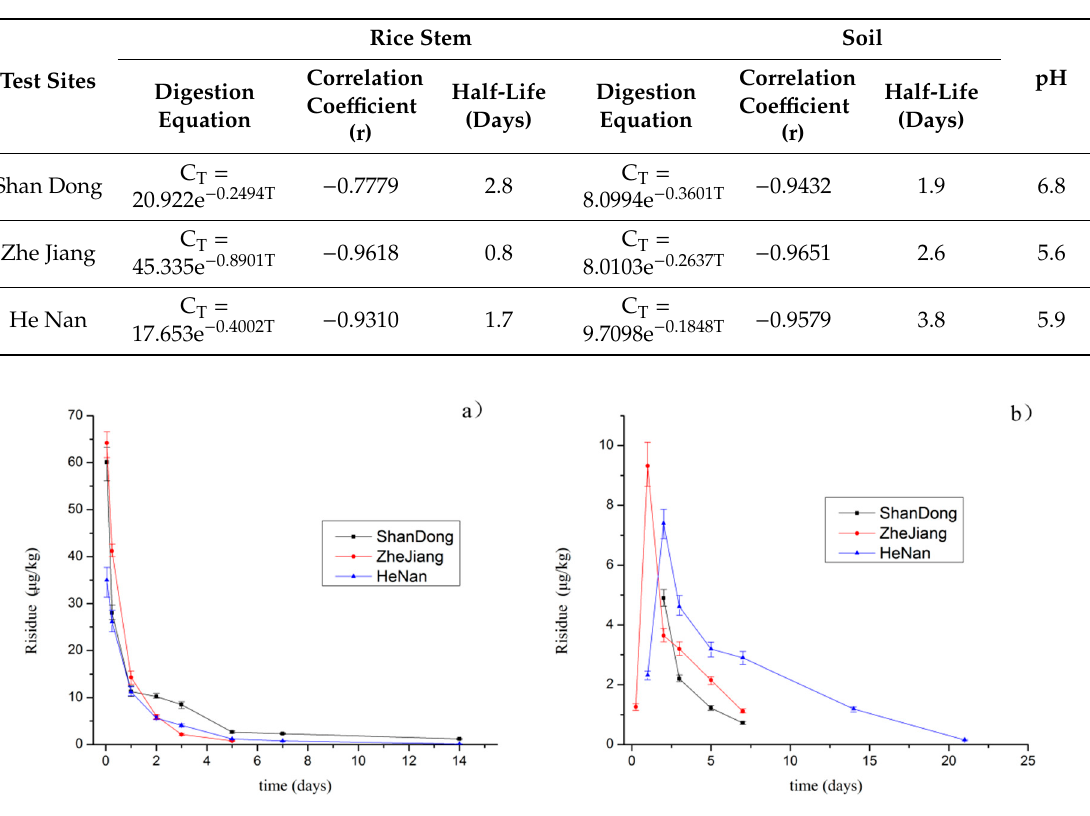
Table 3. Dynamic degradation equation of emamectin benzoate in rice stem and soil ( n = 5).